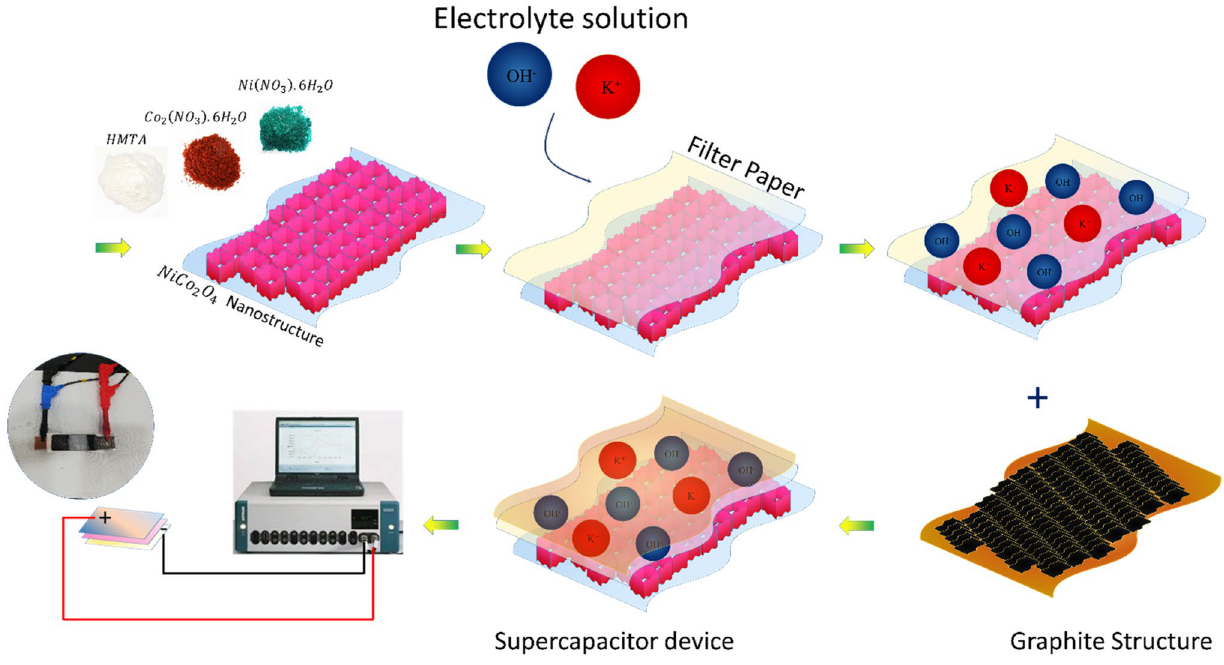
Fig. 1 Schematic illustration of asymmetric supercapacitor design of NiCo